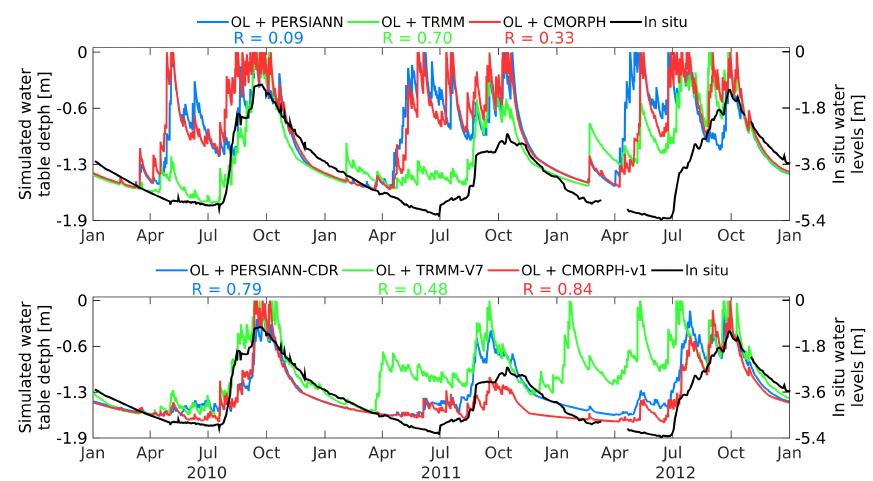
Figure 3. Open-loop (OL) water table depth simulations using the RT (top panel) and reanalyzed (bottom panel) satellite precipitation prod- ucts as forcing compared to in situ measurements at Nalohou. For comparison, the water table depth simulations using in situ precipitation as forcing (not shown here) lead to a correlation of 0.76.